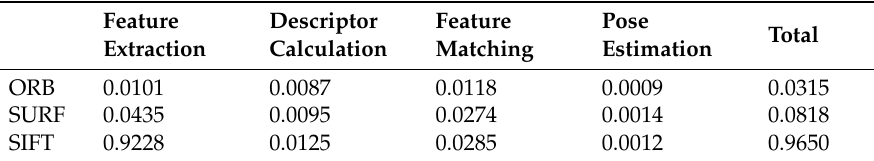
Table 2. The comparative time consumption results